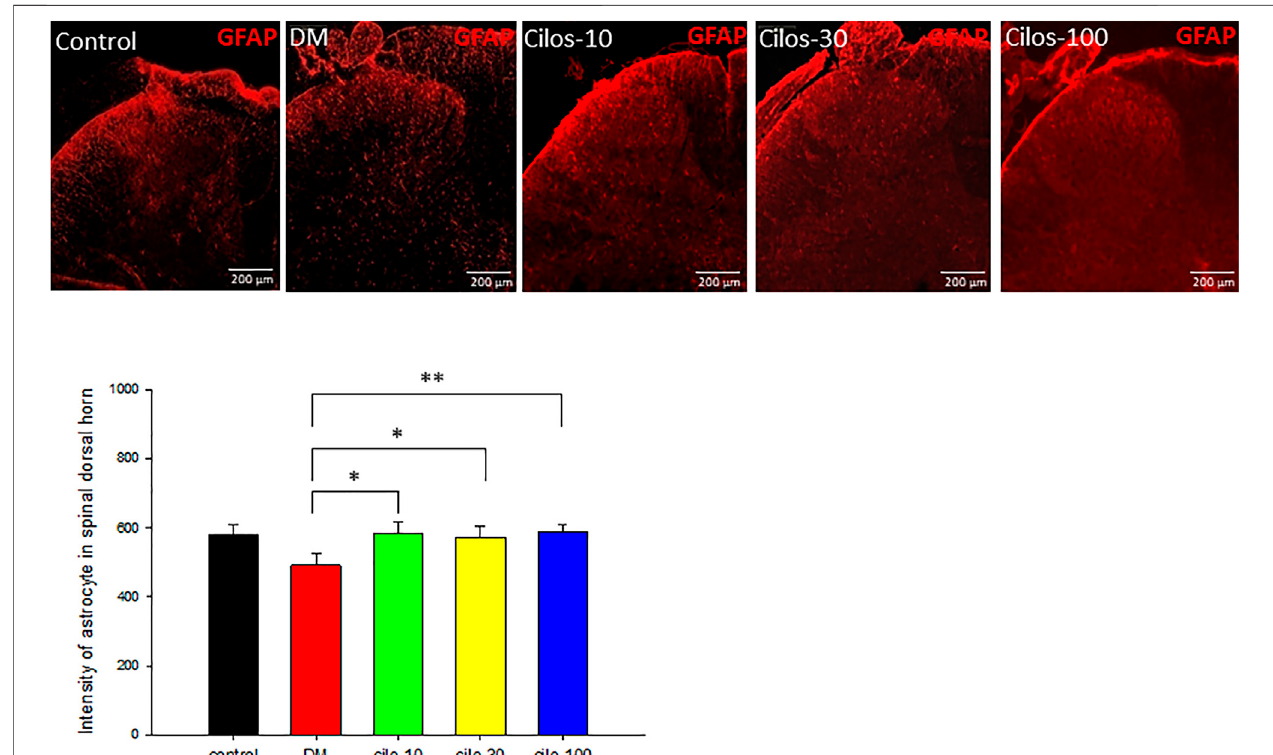
FIGURE 5 | Cilostazol ameliorated levels of activated astrocytes in the spinal dorsal horn (SDH) of streptozotocin (STZ)-induced diabetic (DM) rats. Expressions of astrocytes in the SDH were detected using GFAP (red) via immuno fl uorescence. All cilostazol-treated rats demonstrated signi fi cantly higher levels of astrocytes expressions in the SDH compared to the DM samples. Results are expressed as the mean SEM for a minimum of fi ve rats for each group. Statistical signi fi cances between the DM control and cilostazol DM treatment groups were calculated via the Mann – Whitney U test. * p < 0.05, ** p < 0.01, *** p < 0.001.